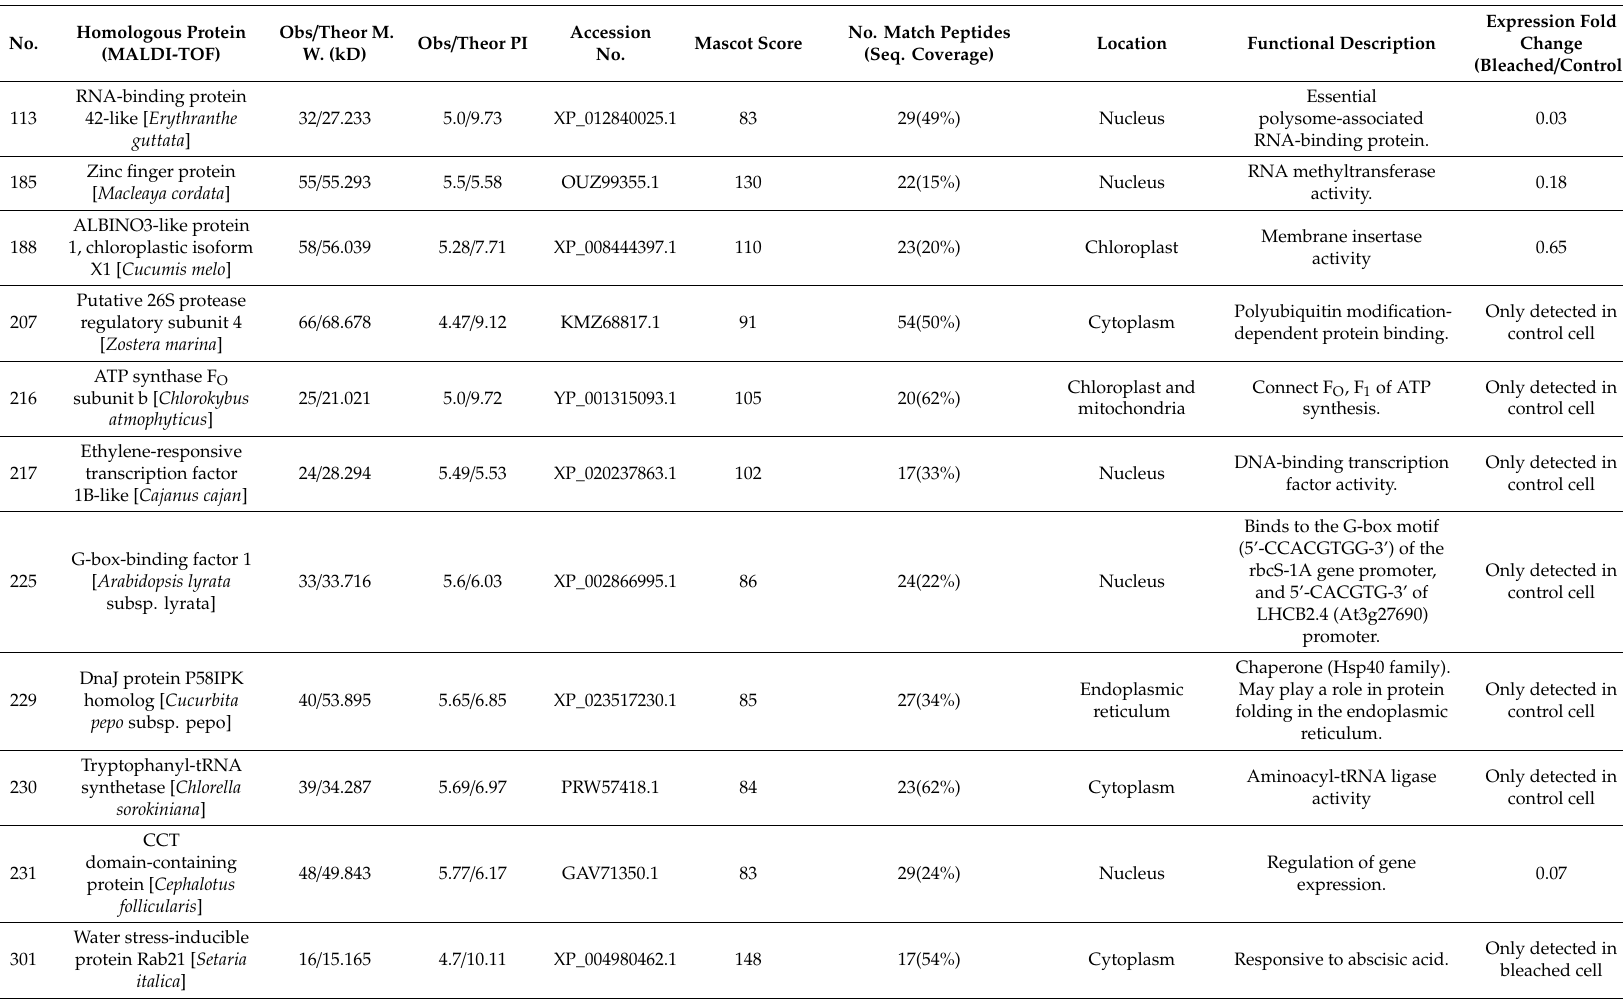
Table 2. List of identified proteins from S. vacuolatus using matrix assisted laser desorption ionization–time of flight mass spectrometry (MALDI-TOF